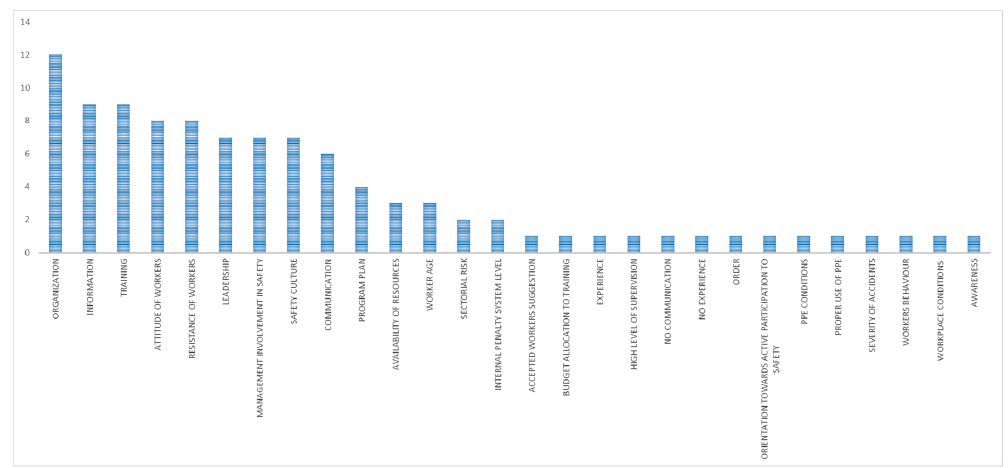
Figure 4. Main contextual factors (in terms of number of occurrences) in organizational interventions with unexpected outcome.